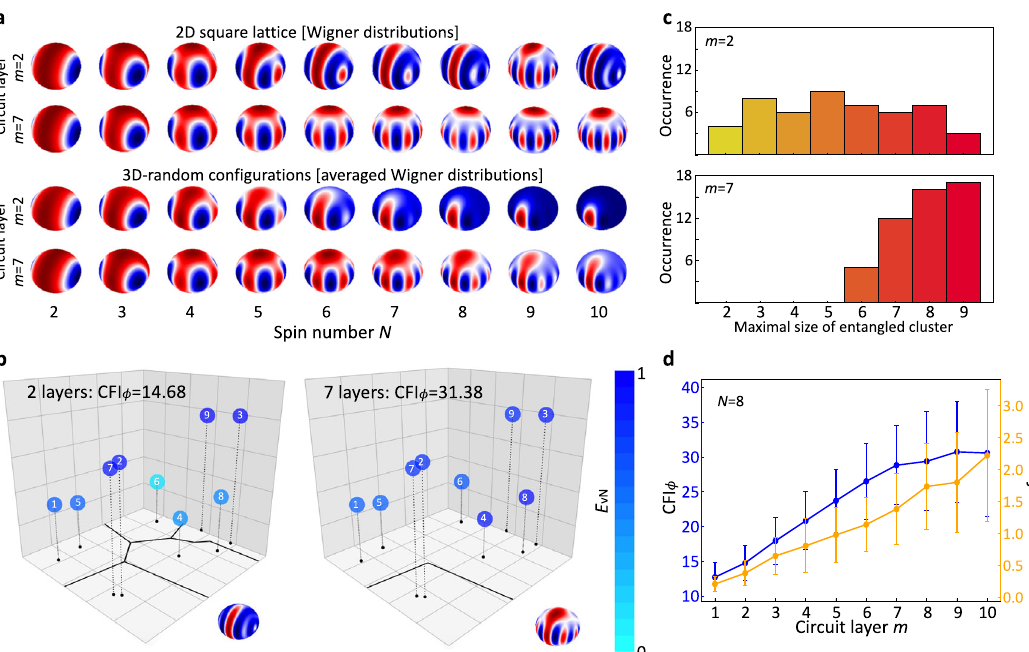
Fig. 3 Entanglement build-up in metrological states. a Wigner distributions versus spin number for m = 2 and m = 7 in the case of 2D square lattice and 3D-random con fi gurations. The projected states into the J = N /2 total angular momentum subspace are shown here. b von- Neumann entanglement entropy for one speci fi c 3D-random con fi guration of 9 spins for m = 2 and m = 7. Individual spins are labeled with an integer 1 through 9 to facilitate the discussion in the main text. The color of each data point corresponds to the von-Neumann entropy noted in the color bar to the right. Entangled clusters are marked by solid black lines. c Histograms depicting the maximal size of entangled clusters for 50 3D-random con fi gurations. The number of spins per entangled clusters increases with circuit depth. d Average CFI (blue) and state preparation time (orange) versus m . Error bars indicate the standard deviations of CFI/state preparation time from different 3D random spin con fi gurations. The state preparation time is given as a unitless quantity f dd T with T ¼